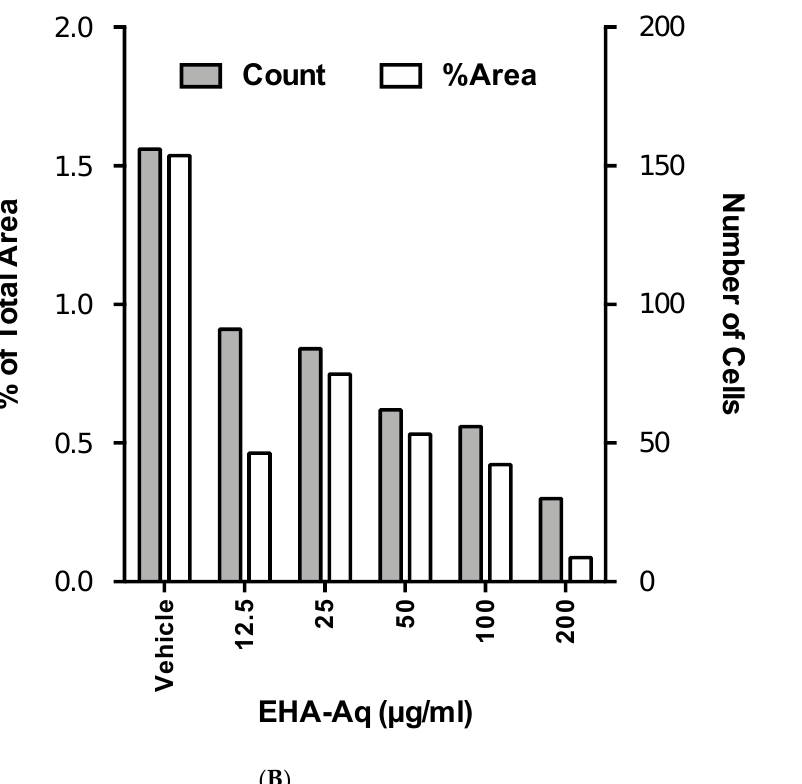
Figure 2. Dose-dependent effects of EHA-Aq fraction on MCF-7 cell proliferation. ( A ) Representative bright-field images of cell confluence captured by Celigo cytometer after 24 h of treatment. ( B ) Bar graphs show nice correlation between surface area occupied by the cells and number of cells after confluence analysis by Celigo software (Cyntellect Inc, San Diego, CA, USA ) .